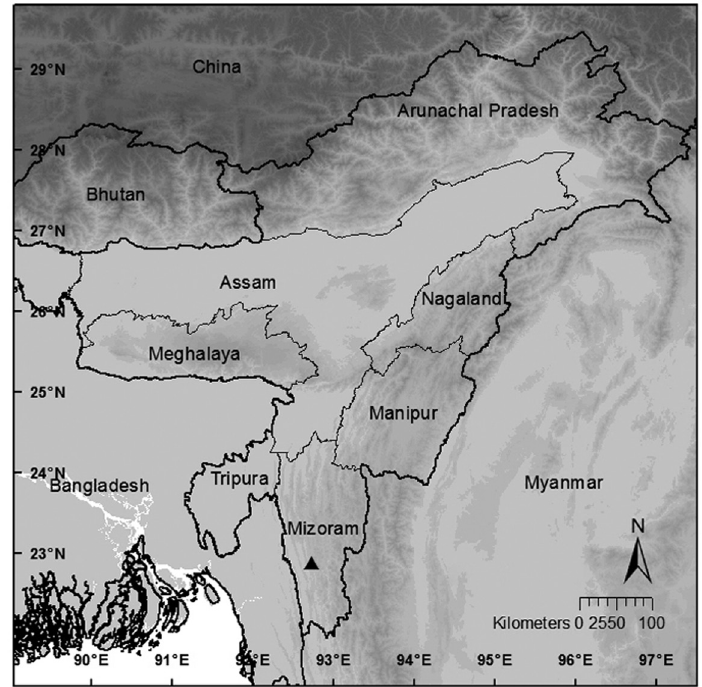
Fig. 63. Map showing the location of B. wengeri C.E.C.Fisch. specimens.